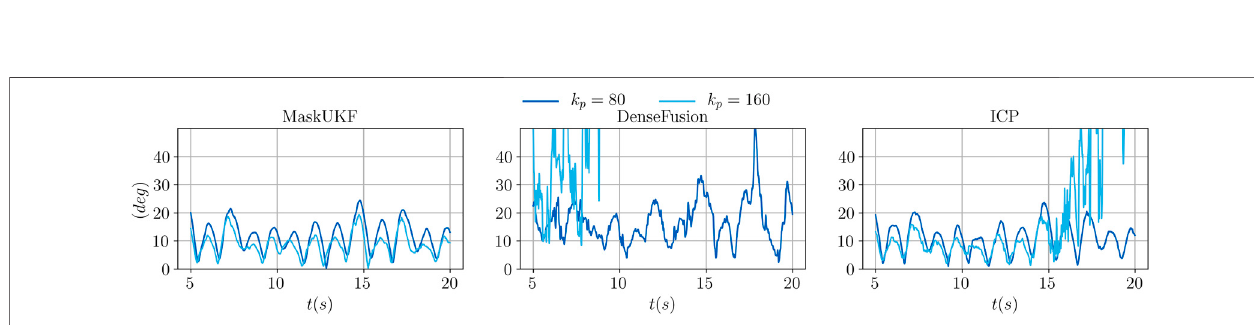
Frontiers in Robotics and AI |